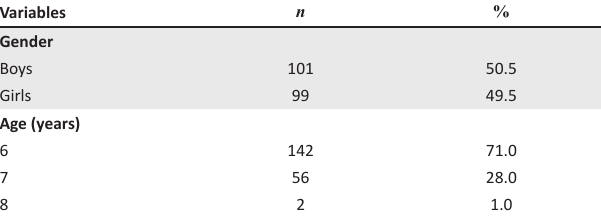
TABLE 2: Distribution of participants ( N = 200) in terms of gender and age.